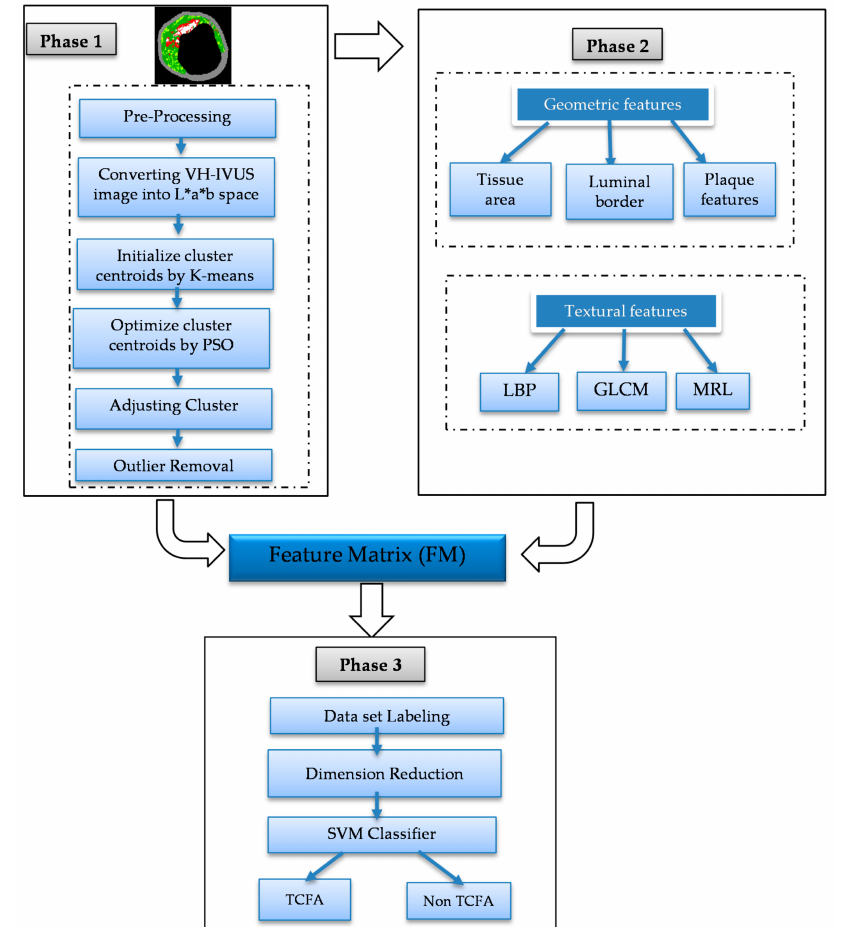
Figure 1. Proposed approach (LBP: Local Binary Patterns feature; GLCM: Grey Level Co-occurrence Matrix feature; and MRL: Modified Run Length